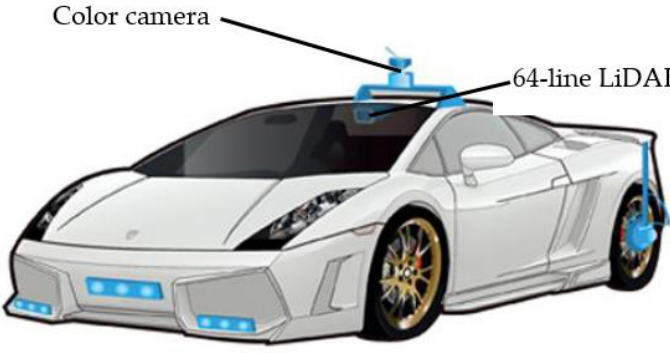
Figure 1. Installation layout of two sensors.